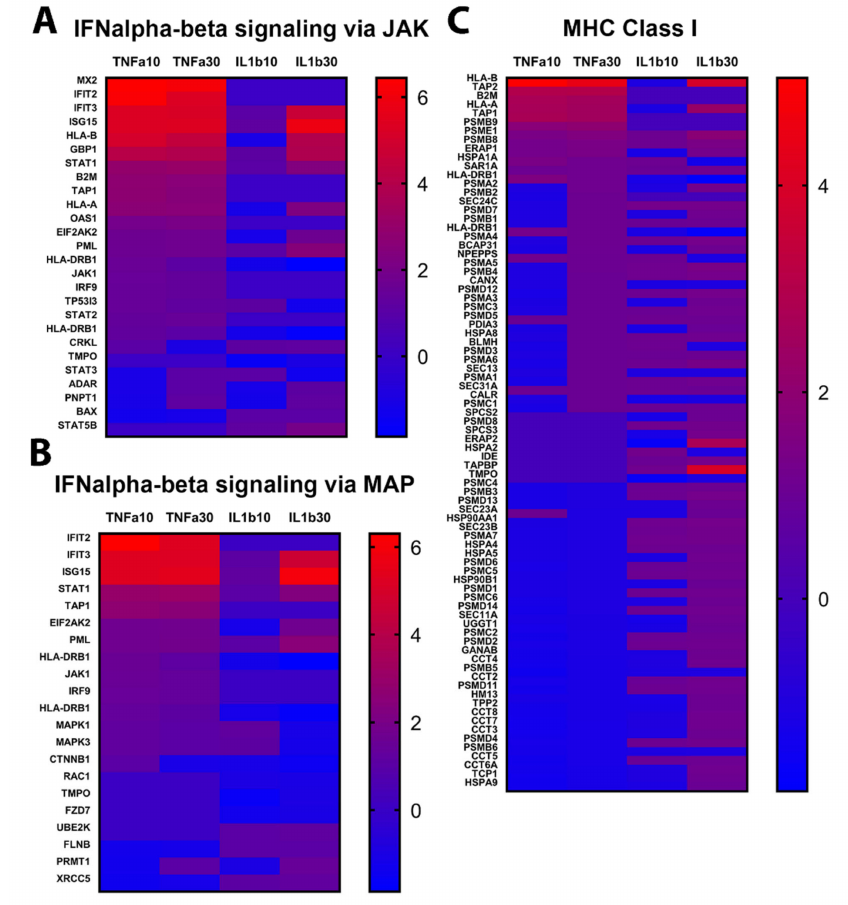
Figure 5. Protein enrichment of inflammatory pathways. Abundance of proteins significantly changed after 24 h of exposure to TNF α or IL1 β (10 and 30 ng/mL), as compared to control cultures. ( A ) IFN signaling via JAK pathway. ( B ) IFN signaling via MAP pathway. ( C ) MHC class I pathway. Red: upregulated, blue: downregulated. Scales indicate fold change compared to control